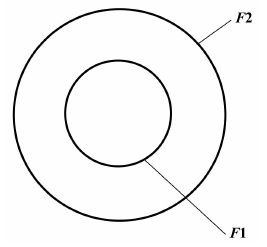
Figure 2. Structure of the high-current